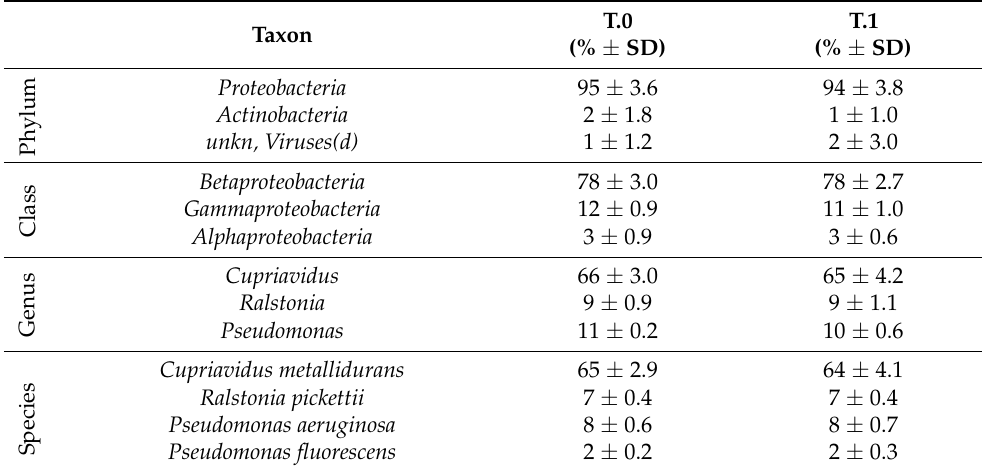
Table 2. Comparison between the percentage abundances of more represented taxa in T.0 and T.1 microbiota. T.0 Taxon